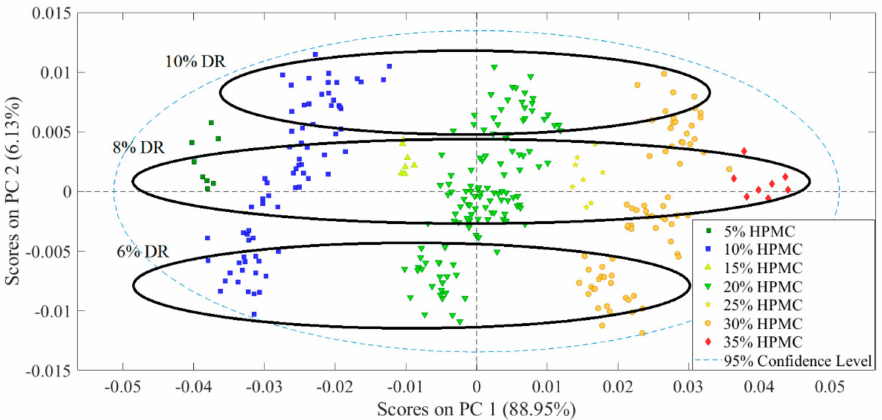
Figure 4. Score plot of preprocessed NIR transmission